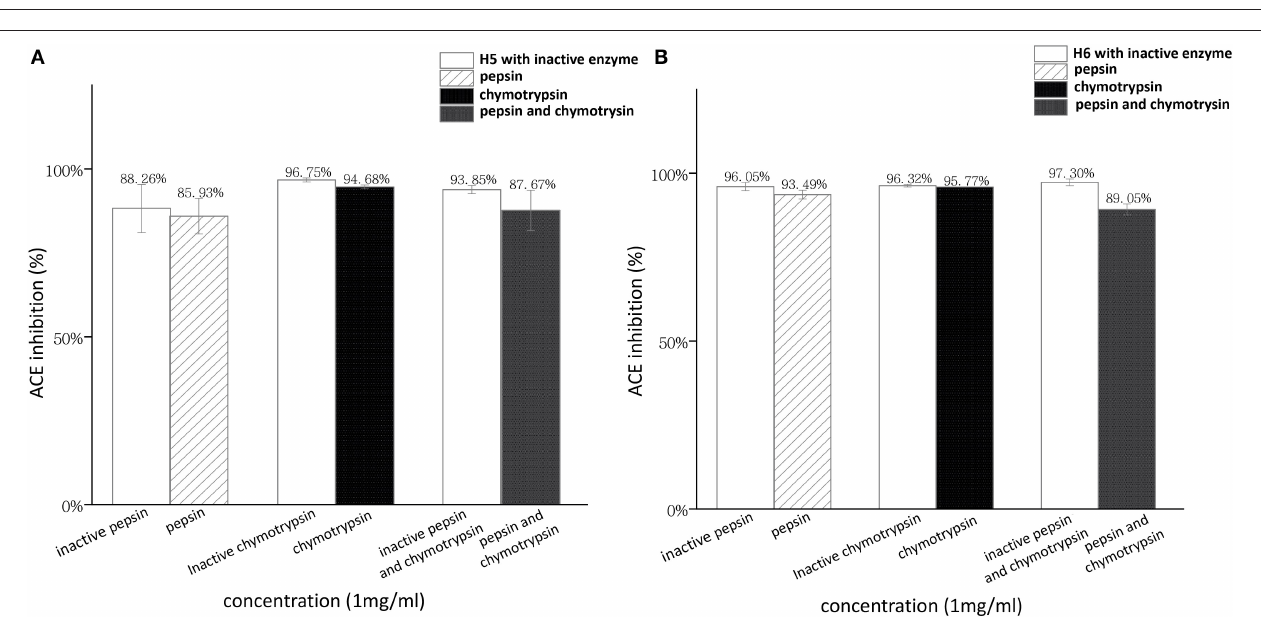
FIGURE 7 | Stability of RWLE peptides against gastrointestinal enzymes (A) peptide H5 and (B) peptide